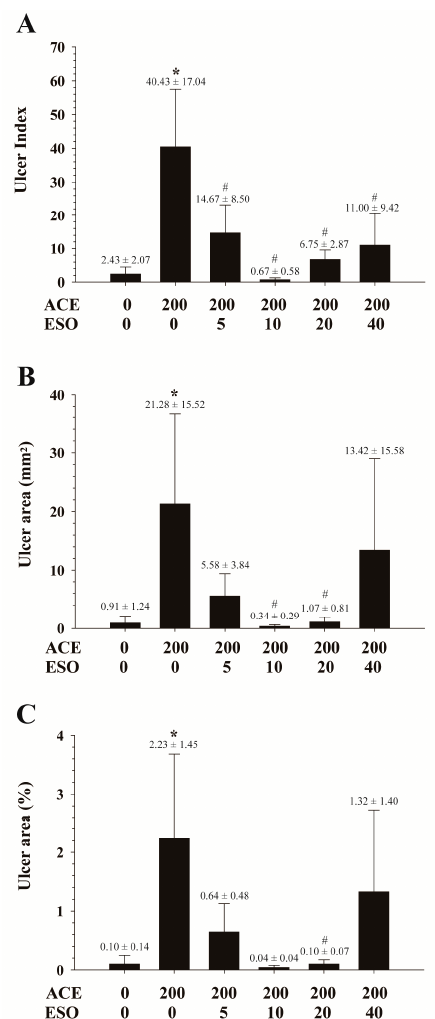
Figure 1. Aceclofenac (ACE) 200 mg/kg-induced gastric ulcers represented by ( A ) ulcer index, ( B ) ulcer area (mm 2 ), and ( C ) relative ulcer area (%) in the absence or in the presence of pre-treatments with esomeprazole (ESO) 0, 5, 10, 20, 40 mg/kg in rats. Each column represents the mean ± SD. *, p < 0.05 vs. control (ACE = 0/ESO = 0 mg/kg); # , p < 0.05 vs. ACE = 200/ESO = 0 mg/kg.